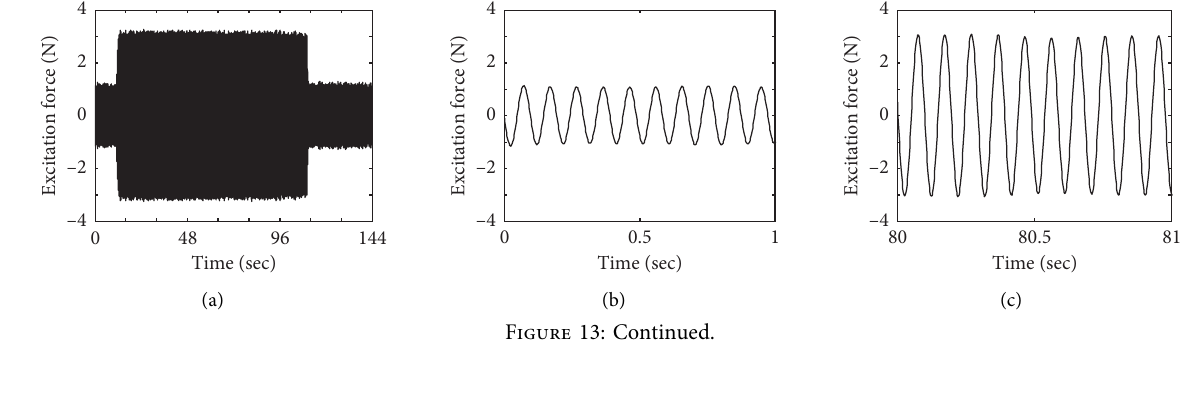
� α � 0 . 5: (a) absorber and (b) primary system. 1 2